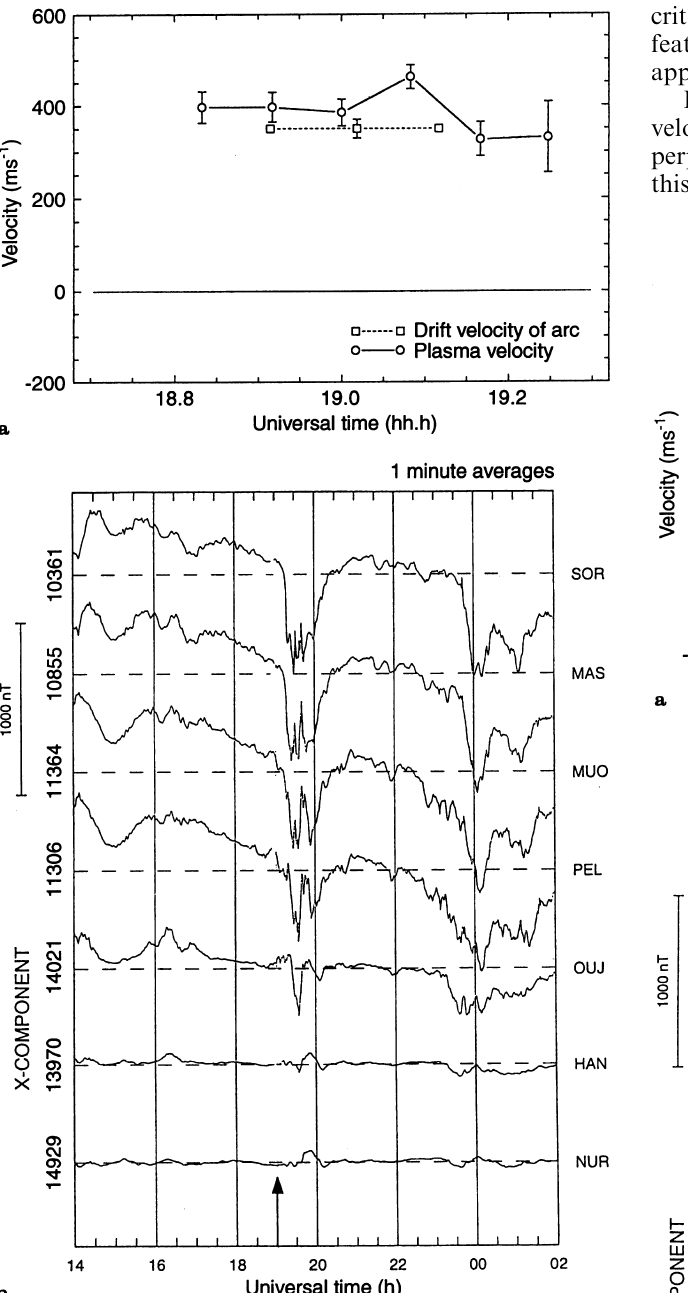
Fig. 3. a Comparison of arc drift velocity (indicated by broken line ) and plasma velocity in the same direction (indicated by continuous line ) for 25 January 1993. b X-component of magnetograms from the IMAGE network for 25–26 January 1993. The arrow indicates the time at which the arc was observed.